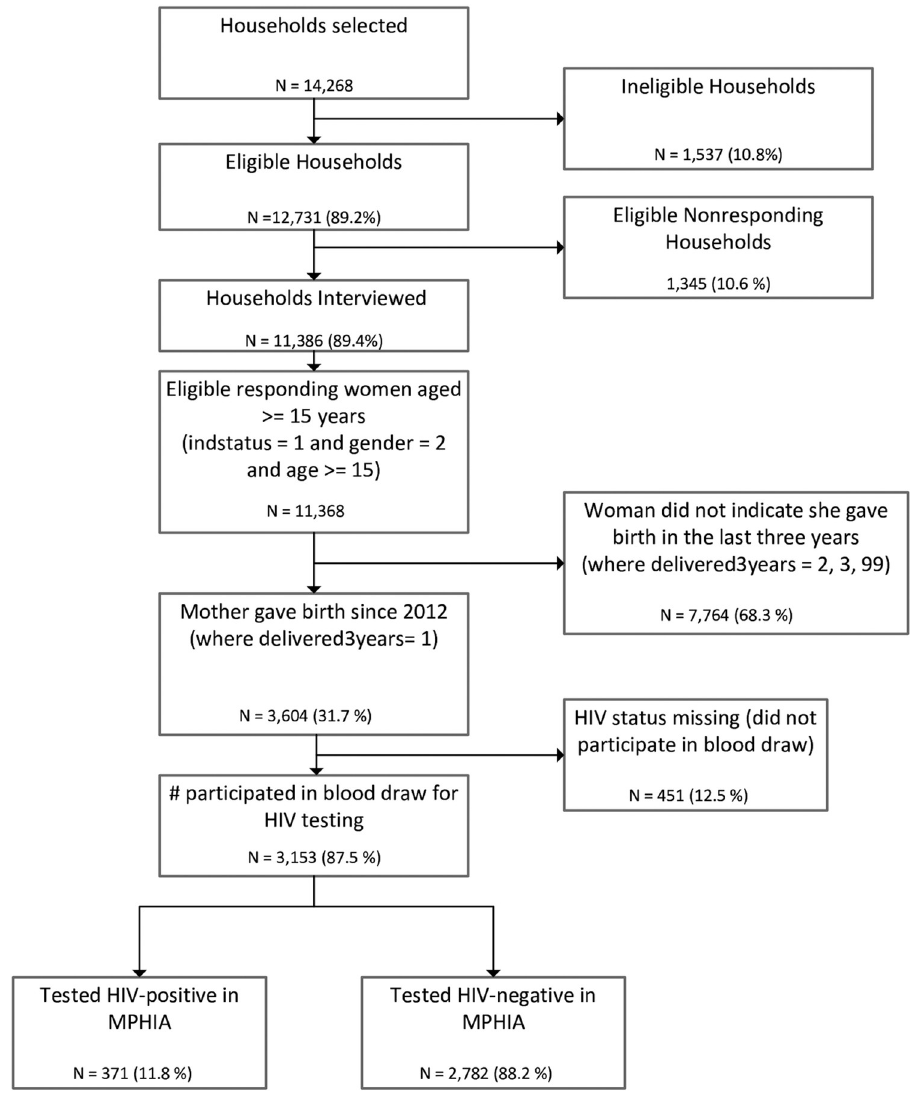
Fig 1. Participant flowchart, 2015–2016 Malawi Population-based HIV Impact Assessment (MPHIA) survey.